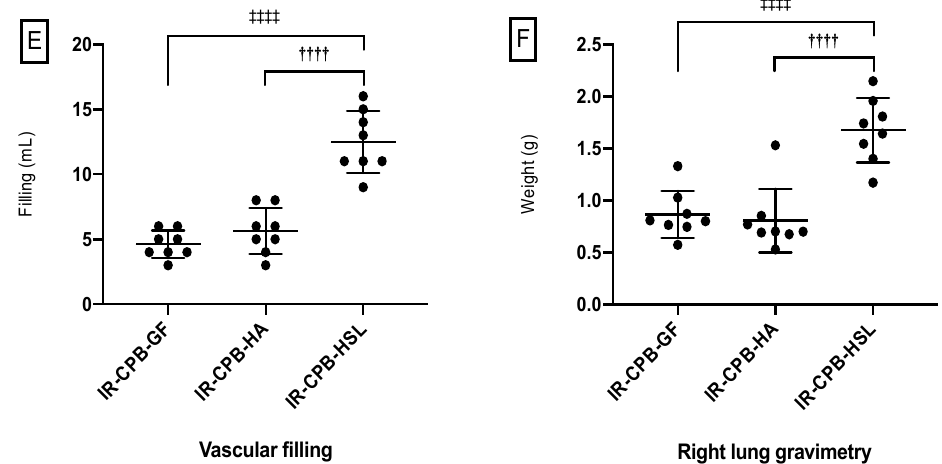
Figure 5. Clinical parameters. ( A ) Heart rate during ischemia. ( B ) Heart rate during reperfusion. ( C ) Mean arterial pressure during ischemia. ( D ) Mean arterial pressure during reperfusion. ( E ) Vascular filling. †††† p < 0.0001 vs. HA. ‡‡‡‡ p < 0.0001 vs. HSL ( F ) Right lung gravimetry. †††† p < 0.0001 vs. HA. ‡‡‡‡ p < 0.0001 vs. HSL. For statistical analyses, ANOVA was used, followed by Tukey’s multiple comparison (post hoc) testing. A result with p < 0.05 was considered to be statistically significant. Data are presented as mean ± SD. Abbreviations: CPB, cardiopulmonary bypass; IR, left lung ischemia–reperfusion; HA, human albumin; HSL, hypertonic sodium lactate.